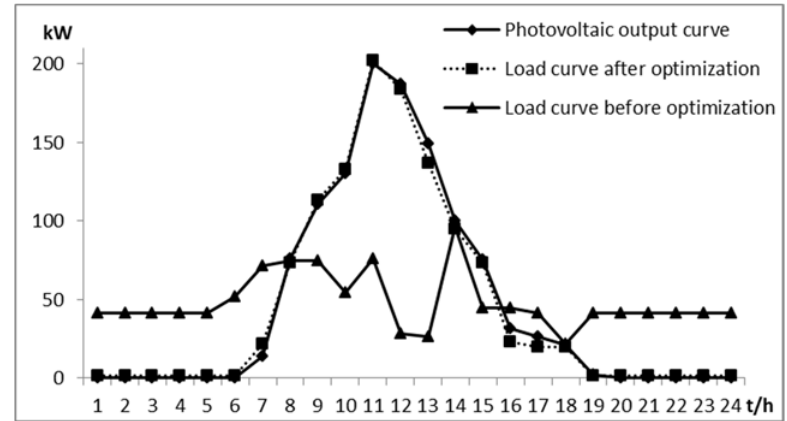
Figure 5. Comparison curve of loads before and after optimization on a sunny winter day. Energies 2018 , 11 , x FOR PEER REVIEW